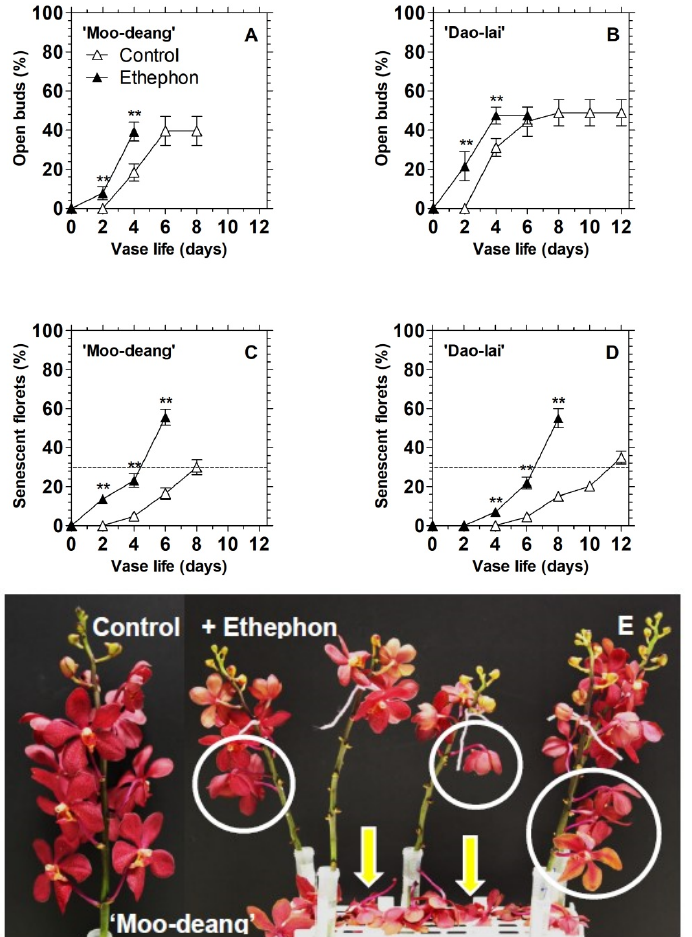
Figure 3. Ethylene enhances bud opening and floret senescence. Effect of ethephon treatment on percent of open buds ( A , B ) and senescent florets ( C , D ) during vase life of cut inflorescences of two Mokara orchid flower hybrids, ‘Moo-deang’ ( A , C ) and ‘Dao-lai’ ( B , D ), and on appearance of petal enrolling (circles) and abscission symptoms (arrows) in ‘Moo-deang’ inflorescences on day 4 of vase life ( E ). Inflorescences were pulsed with either distilled water (control) or 10 µ L · L − 1 ethephon for 24 h, and then transferred to distilled water throughout the experimental period in the observation room. The results represent means of 8–10 replicates ± SE; ** represent significant differences at p ≤ 0.01. The dashed lines in graphs C and D indicate the termination of vase life when 30% senescent florets were